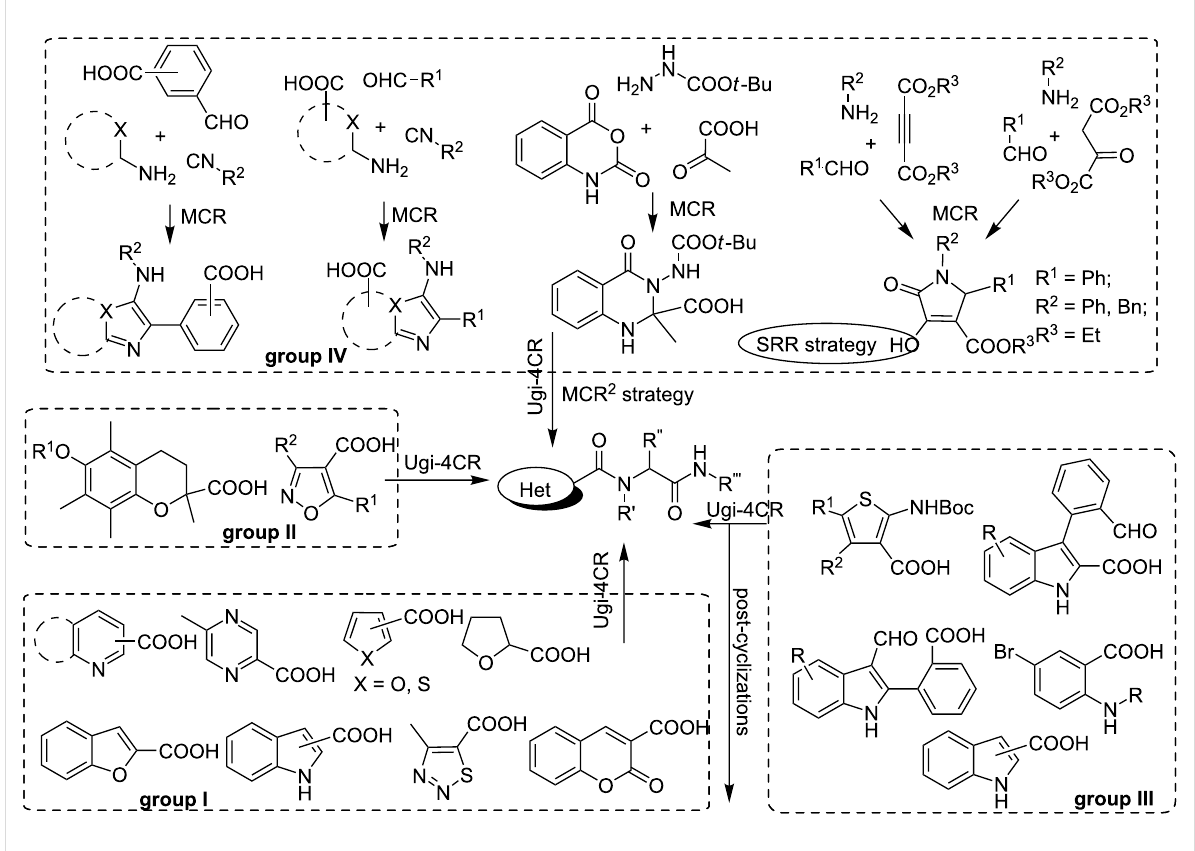
Scheme 1: An overview of heterocyclic acids used in the Ugi